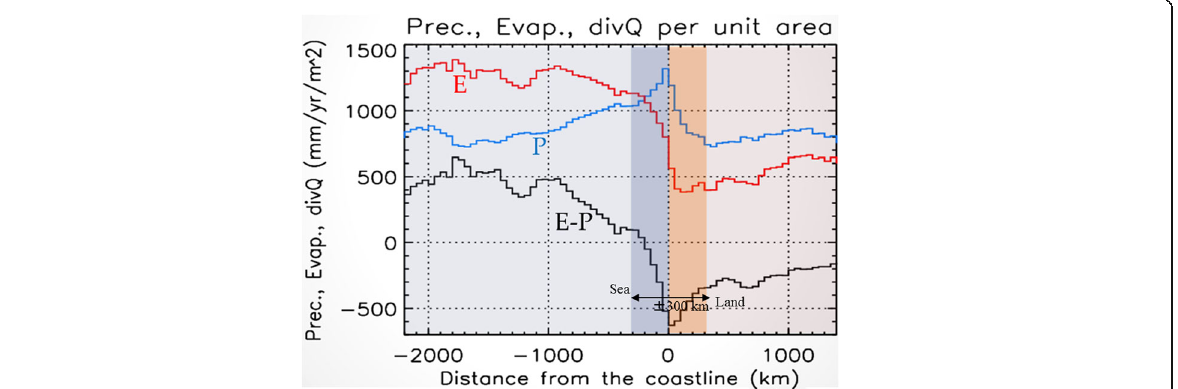
Fig. 12 The 30-year (1981 – 2010) averaged precipitation ( P ) and evaporation ( E ) calculated from the JRA − 55 objective analysis data and their difference ( E − P , corresponding to the horizontal water vapor flux divergence) as functions of the coastal distance for the entire globe (Ogino et al.